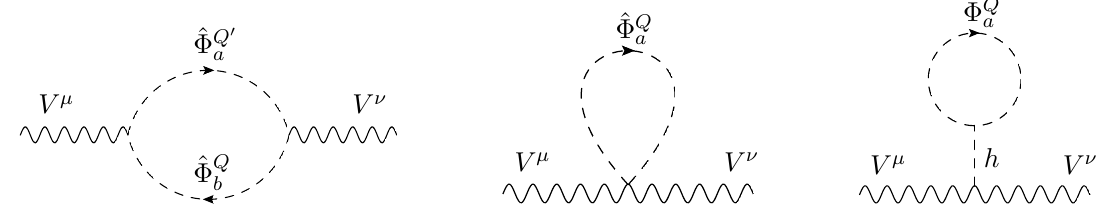
Figure 2. The three different topologies of Feynman diagrams that contribute to Π V V ( q 2 ) with V = W, Z, γ . The last diagram only exists for V = W, Z and has no impact on the S , T and U parameters as it is momentum